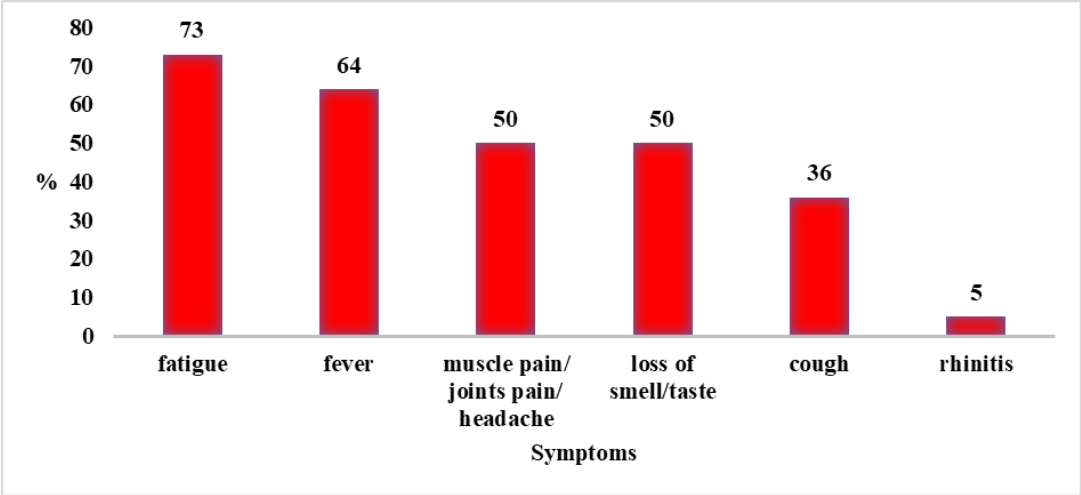
Figure 3. Disease symptoms in people who contracted COVID-19 ( N = 24). Table 2. Comparison of dietary intake and the Dietary Inflammatory Index between participants who contracted and those who did not contract